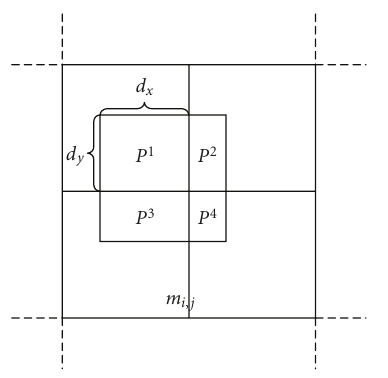
8 subblocks is (cid:0)